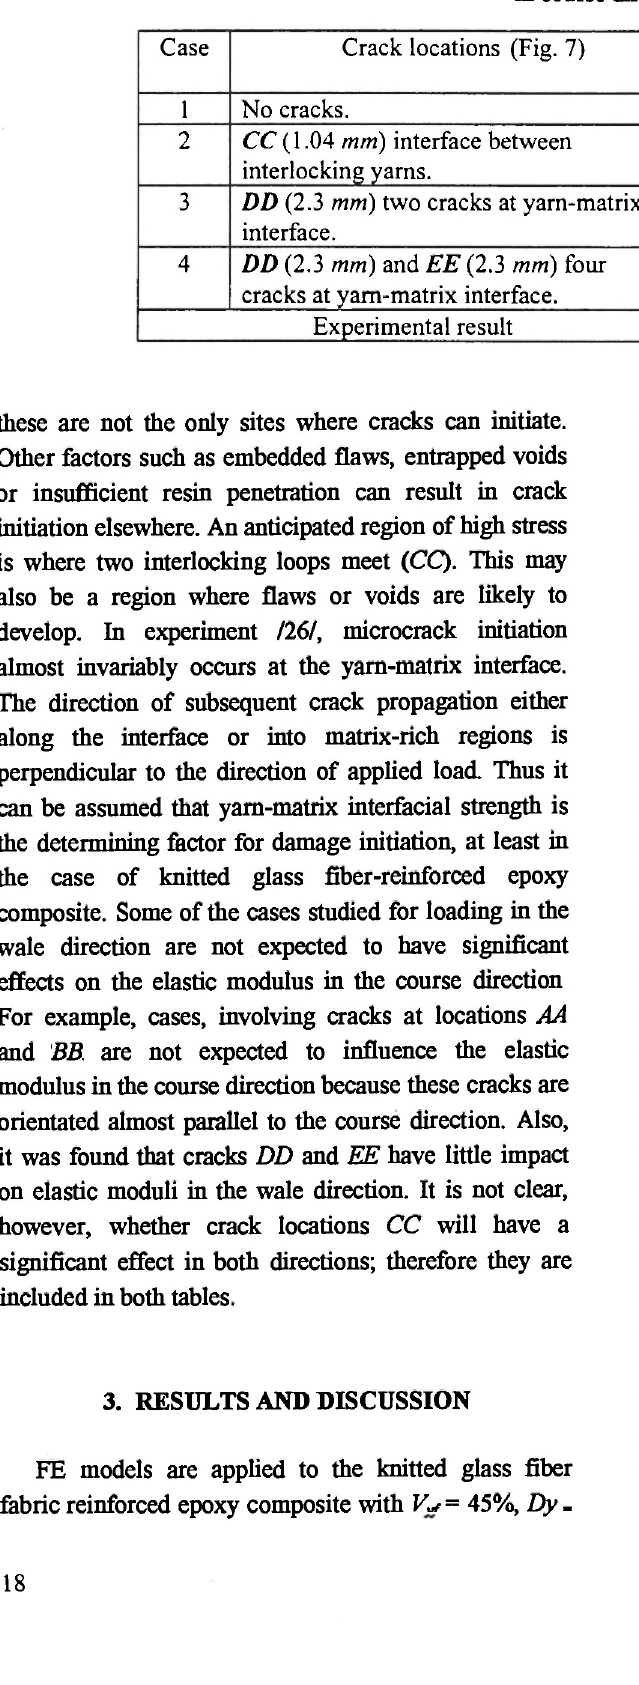
Crack locations and results for elastic modulus in course